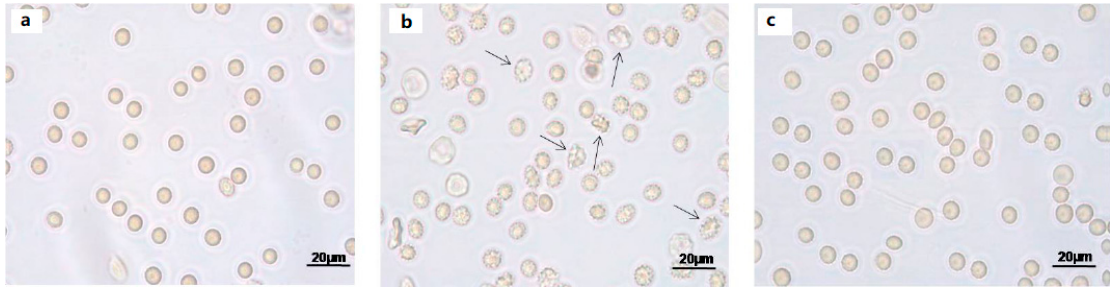
Figure 1. TBARS levels measured as µ M malondialdehyde / mL erythrocytes after treatment with Mel at different concentrations. *** p < 0.001 vs. ctr; n.s. not significant vs. ctr; °°° p < 0.001 vs. either 1 μ M or 10 µ M or 50 µ M Mel, as determined by one way ANOVA followed by Bonferroni’s post hoc test (N = 10).